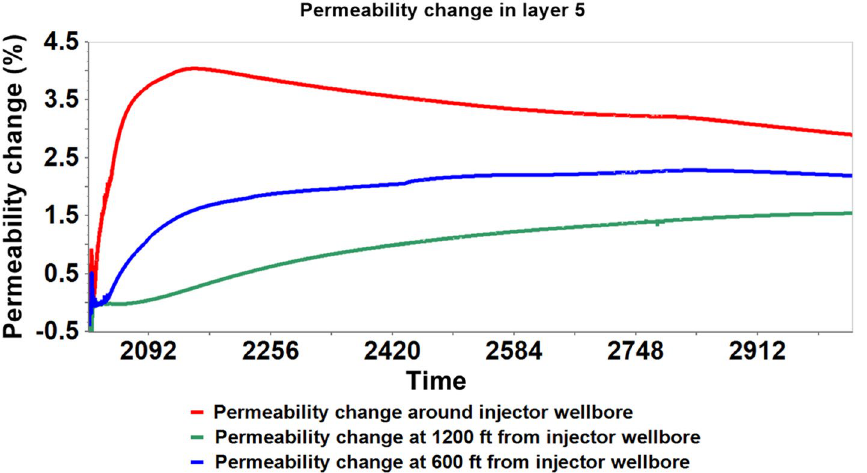
Figure 14. The evolution of stress-induced permeability changes within the bottom caprock layer (Layer 5) at variable distances from the wellbore during 1000 years of post-injection